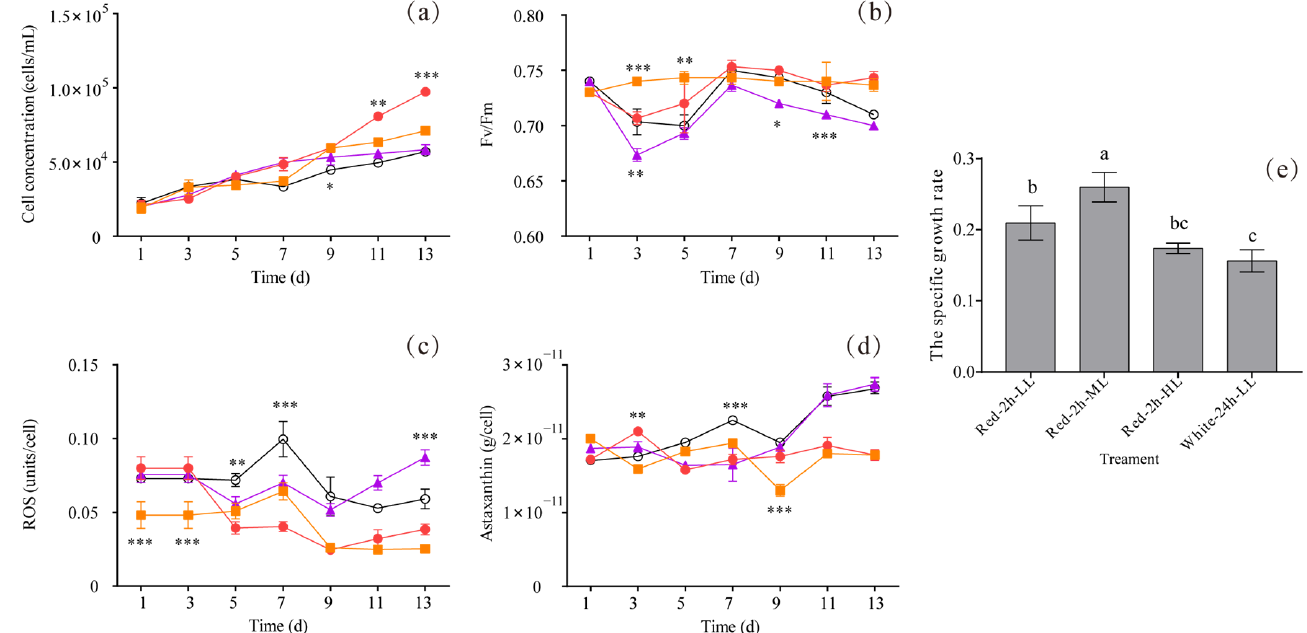
Figure 10. Cell concentration curves ( a ), Fv/Fm curves ( b ), ROS curves ( c ), astaxanthin curves ( d ), and the specific growth rate ( e ) of H. lacustris under combination treatments. The 2/2 h light/dark cycle with red light under 18 µ mol/m 2 · s (Red-2h-LL, orange box), the 2/2 h light/dark cycle with red light under the µ mol/m 2 · s (Red-2h-ML, red circle), the 2/2 h light/dark cycle with red light under 110 µ mol/m 2 · s (Red-2h-HL, purple triangle). Control group: continuous white light under 18 µ mol/m 2 · s (White-24h-LL, open circle). Error bars show the standard deviation for three replicates. In the line charts, asterisks indicate statistically significant differences (Student’s t -test, * p < 0.05, ** p < 0.01, *** p < 0.001). In the bar chart, different superscript letters indicate significant differences among treatments (two-way ANOVA with Tukey correction, p < 0.05).